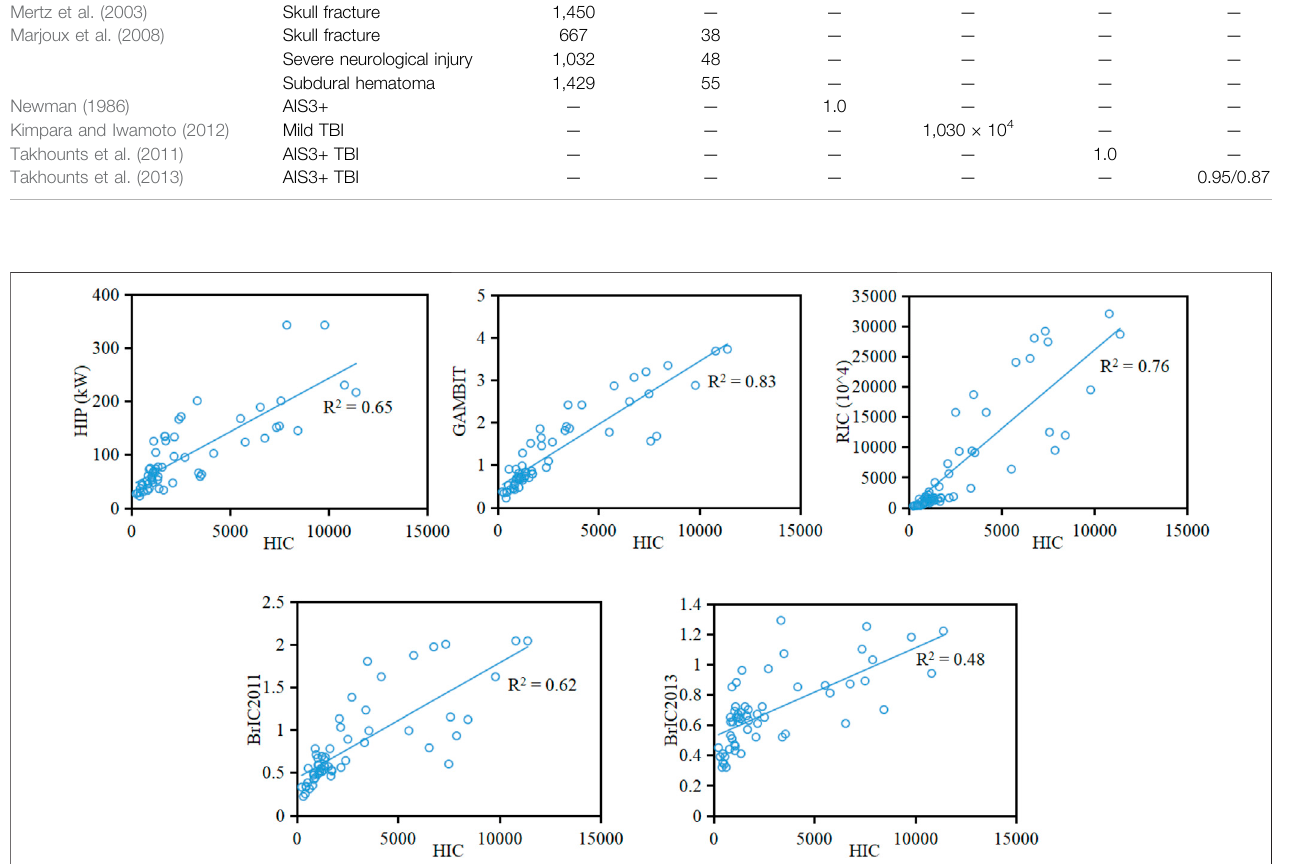
FIGURE 14 | Linear regression between HIC and HIP, GAMBIT, RIC, and